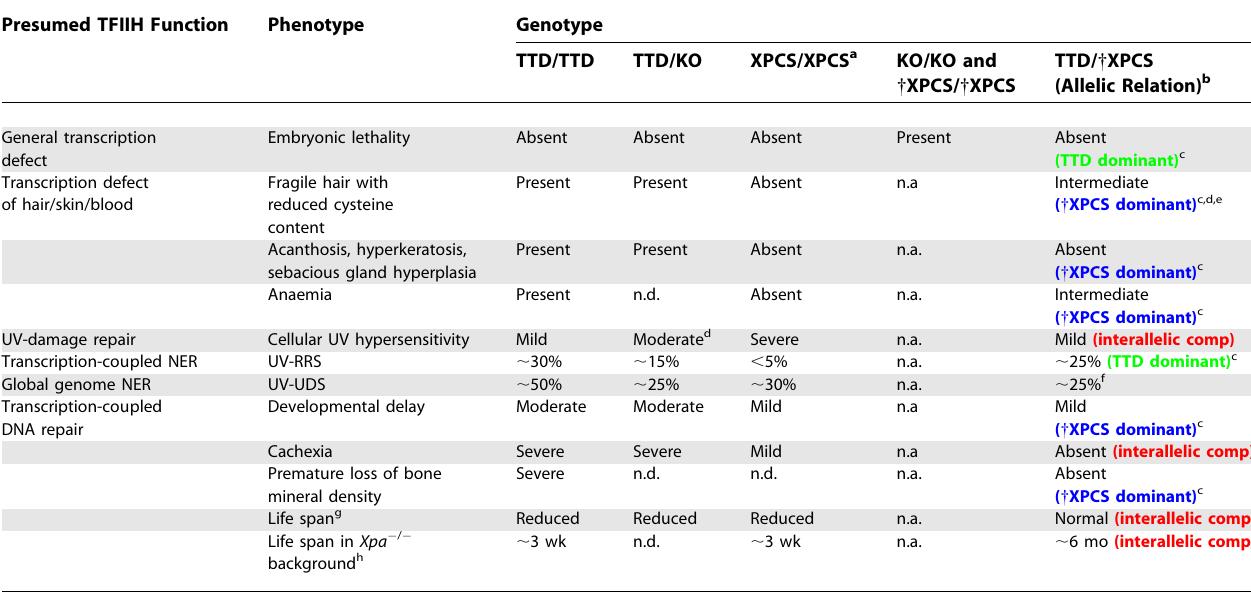
Table 2. Pleiotropic Xpd Biallelic Effects in Mice and